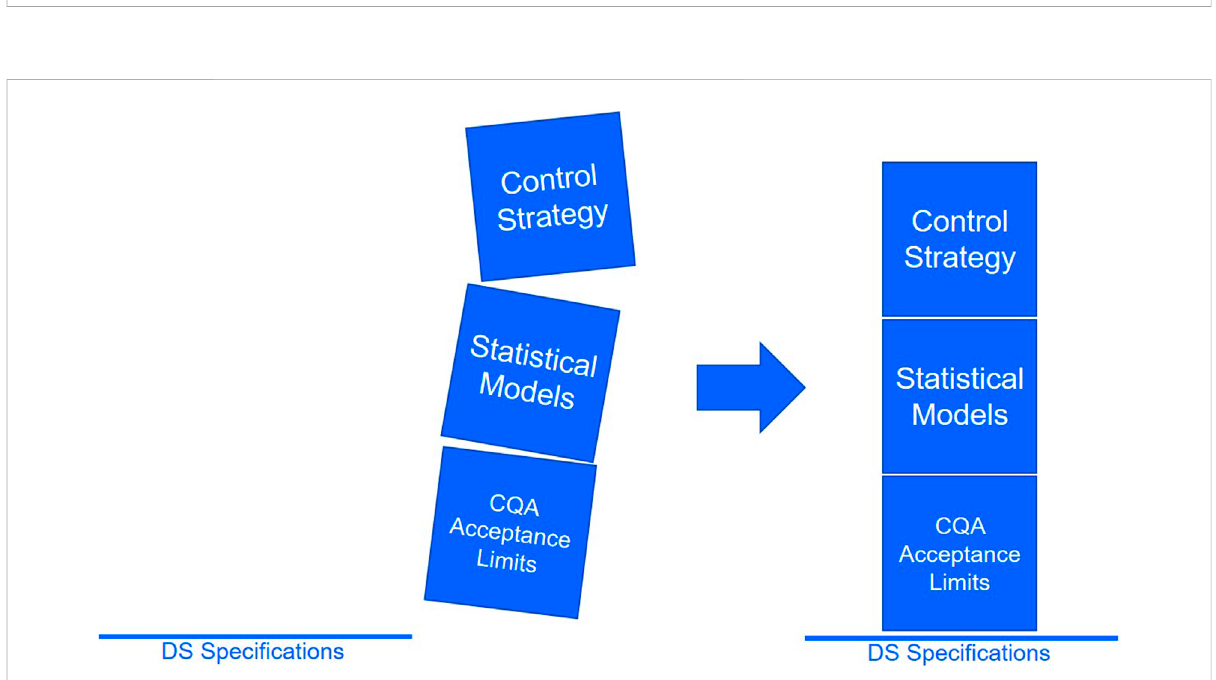
FIGURE 12 Speci fi cation-driven acceptance criteria provide a solid line of reasoning and enable robust control strategies for process parameters.